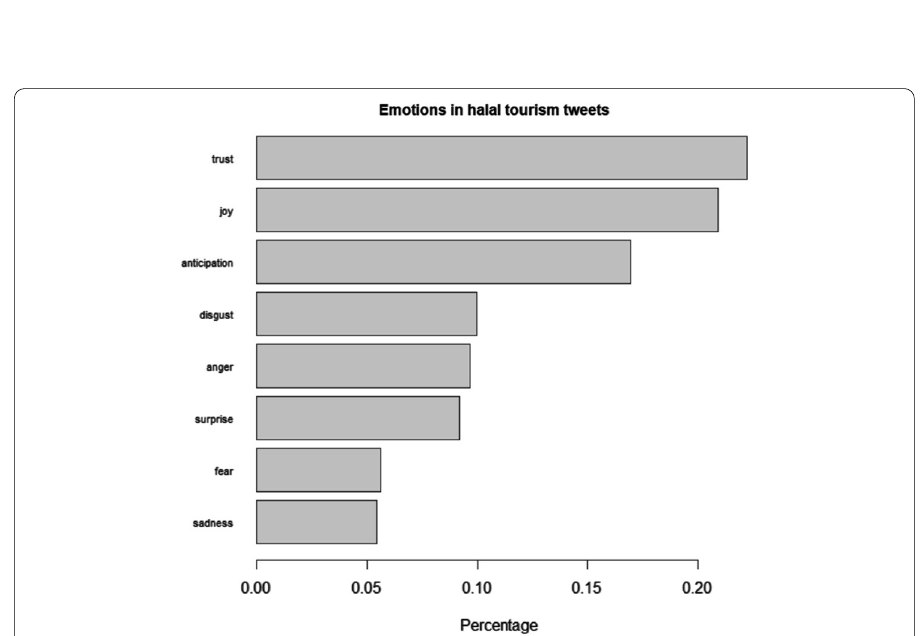
Fig. 8 Emotions expressed in halal tourism tweets (NRC